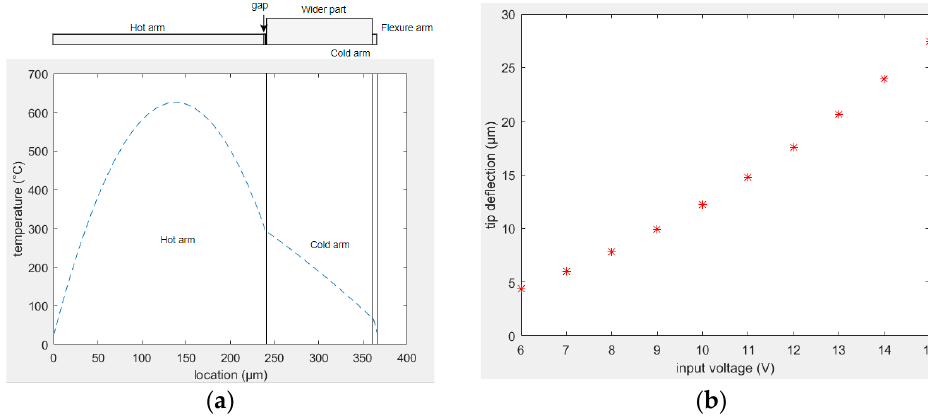
Figure 13. Performance of design C actuator: ( a ) temperature distribution; ( b ) tip deflection.